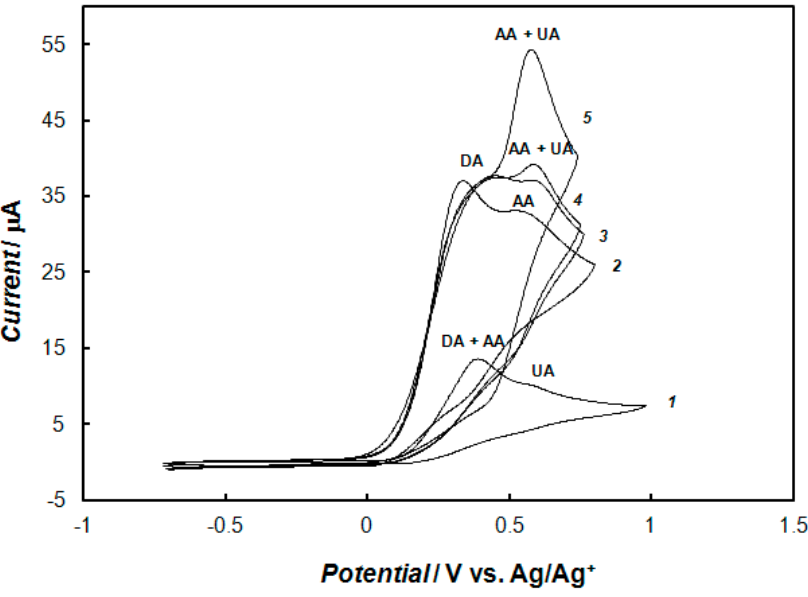
Figure 12. Cyclic voltammograms recorded at the bare gold electrode (curve 1 ), and at the gold electrode modified with the polypyrrole—MCM-48 nanocomposite in 0.1 M of phosphate buffer solution (pH 7.4) containing a mixture of 0.1 mM of dopamine and 10 mM of ascorbic acid (curve 2 ); containing a mixture of 0.1 mM dopamine, 10 mM ascorbic acid, and 0.5 mM uric acid (curve 3 ); containing a mixture of 0.1 mM dopamine, 10 mM ascorbic acid, and 1.5 mM uric acid (curve 4 ); and containing a mixture of 0.1 mM dopamine, 10 mM ascorbic acid, and 5 mM uric acid (curve 5 ). The potential sweep rate was 0.1 V s − 1 .